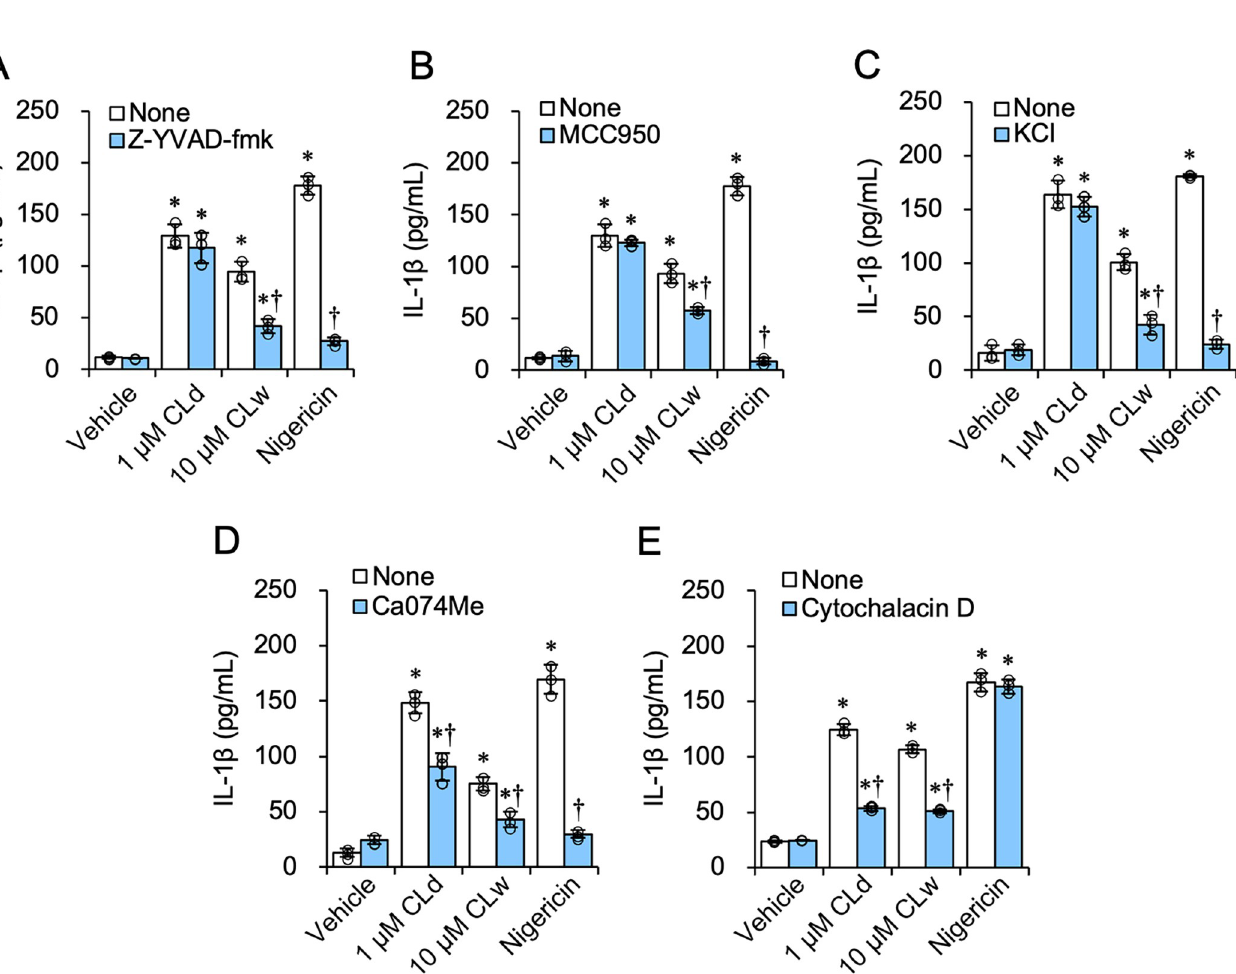
Fig 5. Influence of the inhibitors on the IL-1 β -producing activity of CLd and CLw. LPS-primed THP-1 cells were pretreated with following inhibitors: 20 μ M of the caspase-1 inhibitor Z-YVAD-fmk (A); 2 μ M of the NLRP3 inhibitor MCC950 (B); 25 mM KCl for inhibition of K + efflux (C); 20 μ M of the cathepsin B inhibitor Ca074Me (D); and 20 μ M of the phagocytosis inhibitor cytochalasin D (E) or with vehicle for 1 h. The vehicle control is a medium containing 2% DMSO. Cells were then treated with 1 μ M CLd or 10 μ M CLw for 3 h. The IL-1 β levels in the culture supernatants were assessed by ELISA. Data are presented as the mean ± SD (n = 3) and are representative of three independent experiments. � P < 0.05 compared with the vehicle ( μ c < μ i); † P < 0.05 compared with the none ( μ c > μ i) by one-way ANOVA followed by Dunnett’s test.